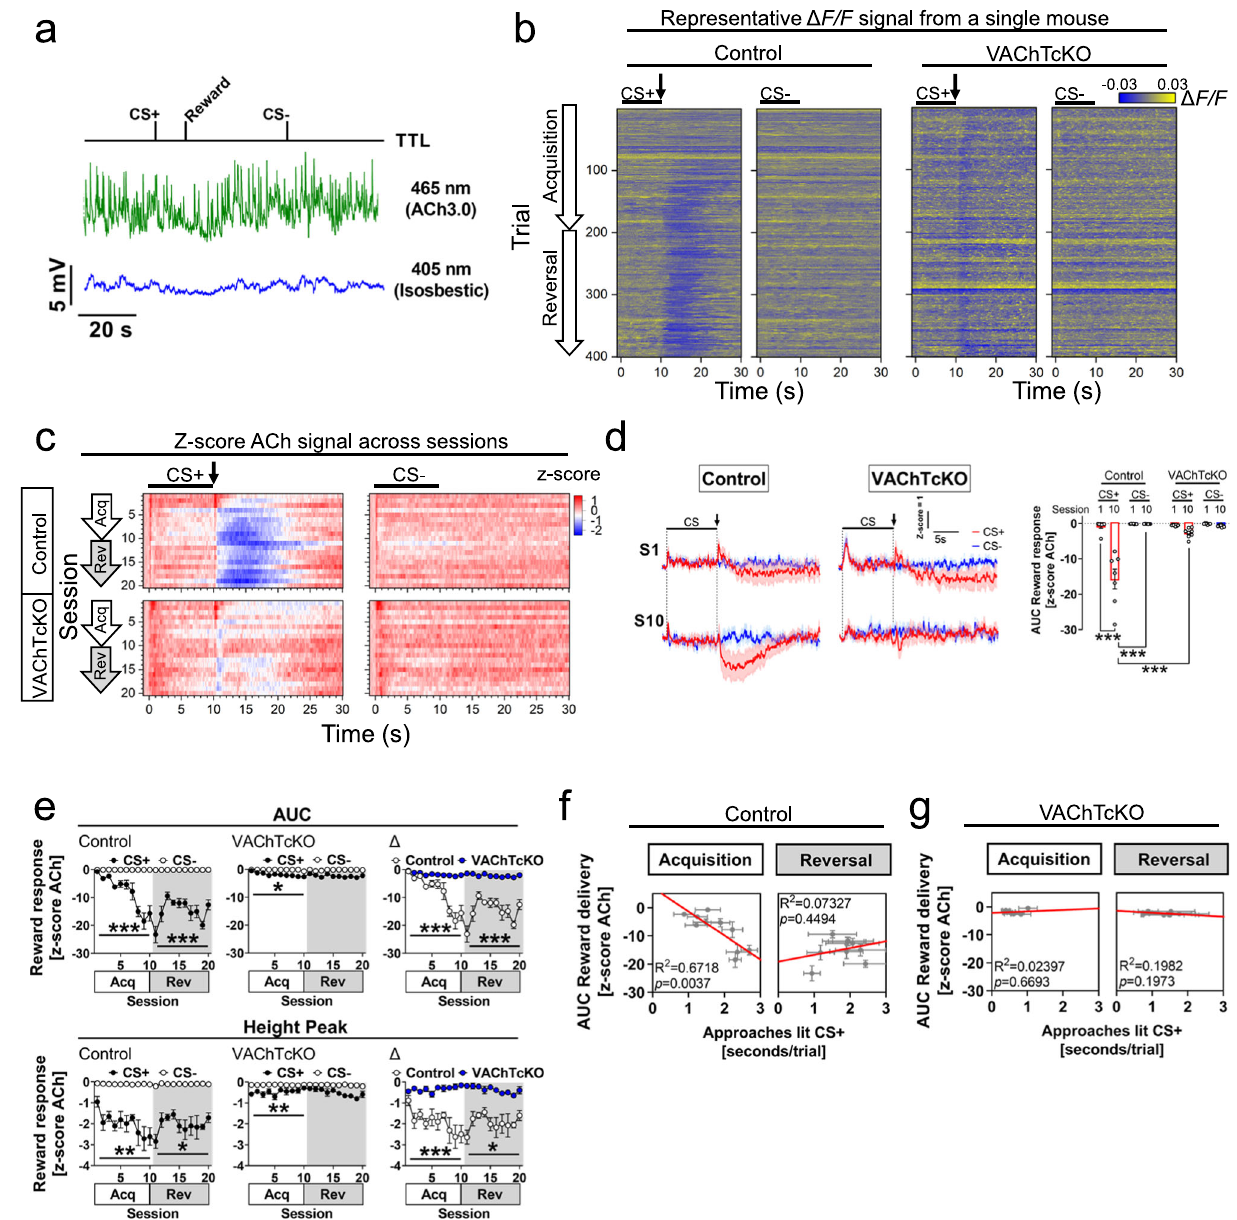
Fig.4|De fi citsinacetylcholinereleasefromcholinergicinterneuronsunderlie impaired approach behaviours to reward-predicting stimuli. a Representative fi bre photometry recording from a control littermate mouse showing raw fl uor- escence signalat 465nm (green, ACh3.0)and isosbestic405nm (blue).A TTLinput signal was used to time-lock CS onset and reward delivery. b Representative trial- by-trialheatmapsshowingnucleusaccumbensAChdynamics( Δ F/F)fromacontrol littermate and VAChTcKO mouse performing the Autoshaping task (Session 1 → 10, acquisition: trials 1 → 200; Session 11 → 20, reversal: trials 201 → 400). Bar indicates CS presentation (10s), arrow bar shows reward delivery. c Heatmaps illustrating trial averageAChdynamics( z -score)acrossacquisition(Acq,S1 → S10)andreversal(Rev, S11 → S20)sessions(CS+,leftpanels;CS-,rightpanels).BarindicatesCSpresentation (10s) and arrow bar reward delivery. d (left) Trial average of CS+ (red) and CS- (blue)AChrecordingsduringacquisitionsessions(S1,S10)incontrollittermateand VAChTcKO mice. Bar indicates CS presentation (10s), arrow bar indicates reward delivery.(right)Areaunderthe curve (AUC)ofAChsignal( z -score)afterCS+offset (reward delivery) and CS- offset. In contrast to the fi rst training session (S1), The AChsignalsigni fi cantlyreducedintrainedcontrolmice(S10),butVAChTcKO(one- wayANOVA, F(7,52)=30.31, p <0.0001). e (Top panels)AUC ofAChsignalafter CS